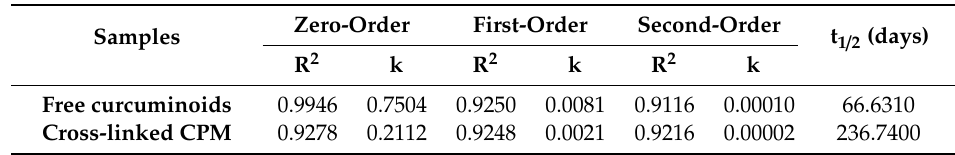
Table 3. Values of coe ffi cient of determination (R 2 ), rate constant (k) and half-life of degradation (t 1 / 2 ) for free curcuminoids and cross-linked curcuminoids microcapsule